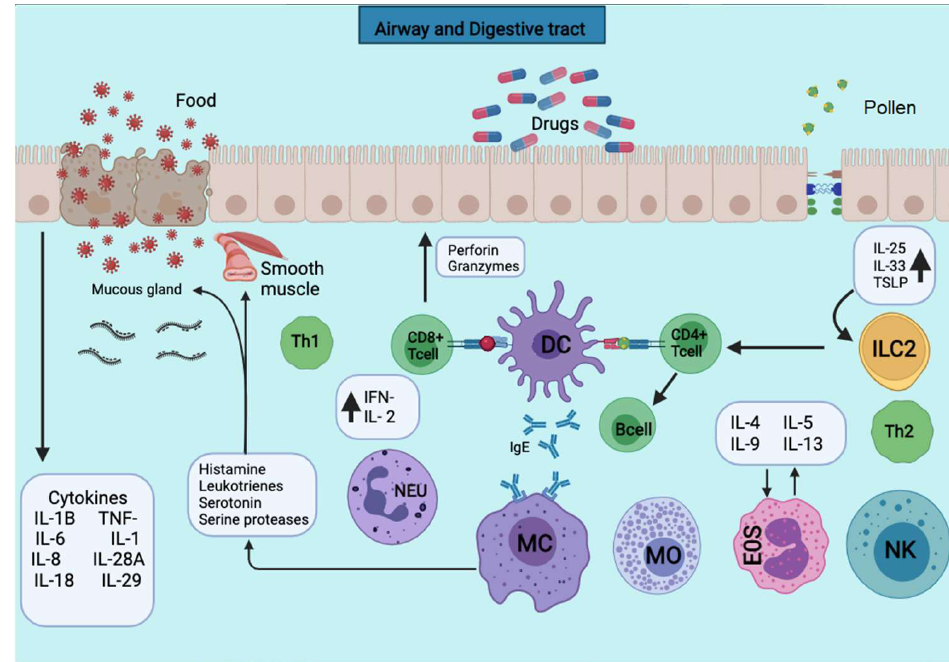
Figure 2. APCs present the antigens to the CD4+ T cells subpopulation for activation. APCs take up the first sensitizing contact with the antigen, bind it to MHC class II molecules, and expose it to the membrane. APCs take up the first sensitizing contact with the antigen, which processes and binds it to MHC class II molecules and exposes it to the membrane. Several cytokines such as TNF-a, IL-1, IL-4, IL-5, IL-6, IL-13, MIP-1a, and various colony-stimulating factors such as GM-CSF and IL-3 are released. The triggering of the allergic reaction is stimulated by the production of IgE by B lymphocytes. The production of IgE stimulates the triggering of the allergic reaction by B lymphocytes. The IgE will bind to mast cells and basophils for degranulation and the release of several